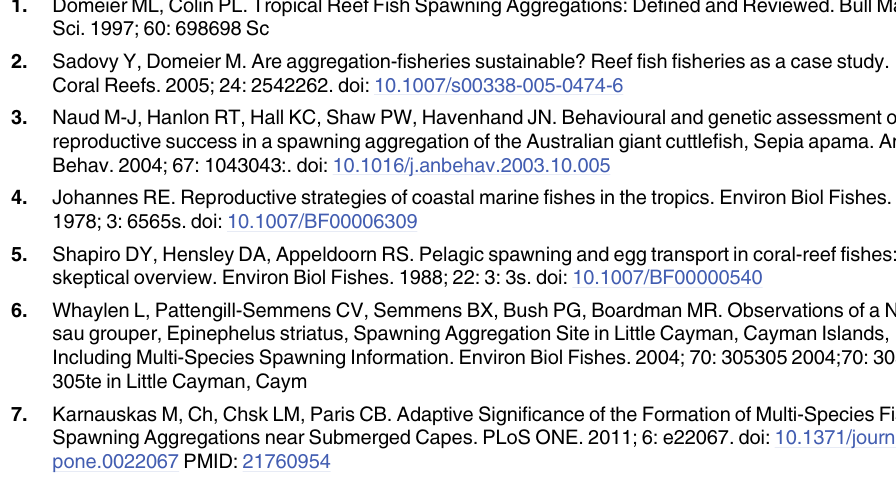
S3 Fig. Replacing variance by standard deviation in the objective function. This figure is a recasting of Fig 6 in the main text, but with the variance in eq (1) replaced by the standard devi- ation. Note that the positions of the local maxima are different in this plot than in Fig 6, illus- trating how the particular values of the “ risk penalty ” parameter depend on the problem formulation. This formulation of the problem admits a probabilistic interpretation: the proba- bility that (cid:2) x ð m Þ lies above the dashed lines is fi xed for each line. (PDF) S4 Fig. A probabilistic objective for which the optimal solution is a minimizer. This plot investigates an objective of minimizing the probability that reproductive success rate falls below a fixed threshold, 2 . The five lines represent five different such thresholds. Each point on a line represents the probability that the reproductive success rate (cid:2) x m ð Þ falls short of the corresponding threshold, and the trajectory of the line illustrate how this probability changes as the size of the spawning window increases. The black dots indicate the spawning window size that minimizes the risk of falling below the threshold. Note that each dot corresponds to a different value of m , so if one knows m , one can infer the tolerance threshold 2 .